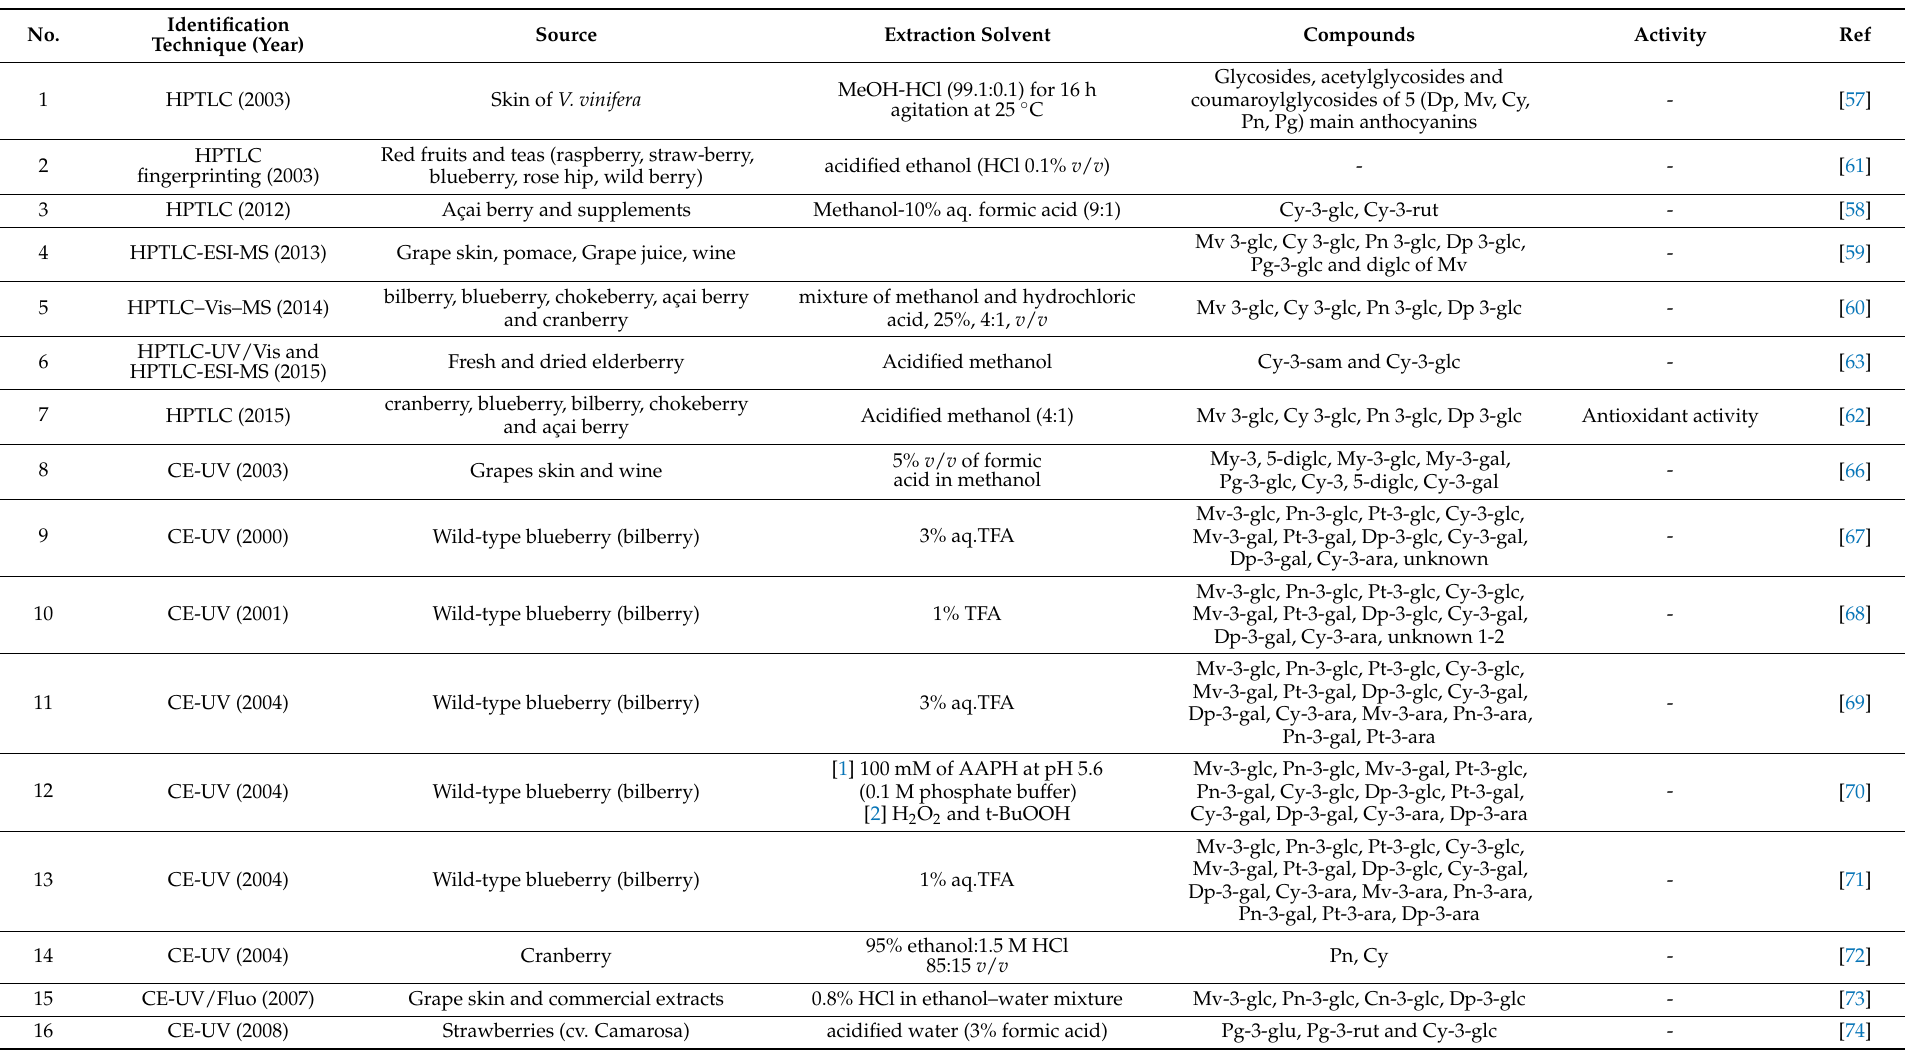
Table 3. HPTLC and CE analysis of fruit/berries for analysis of